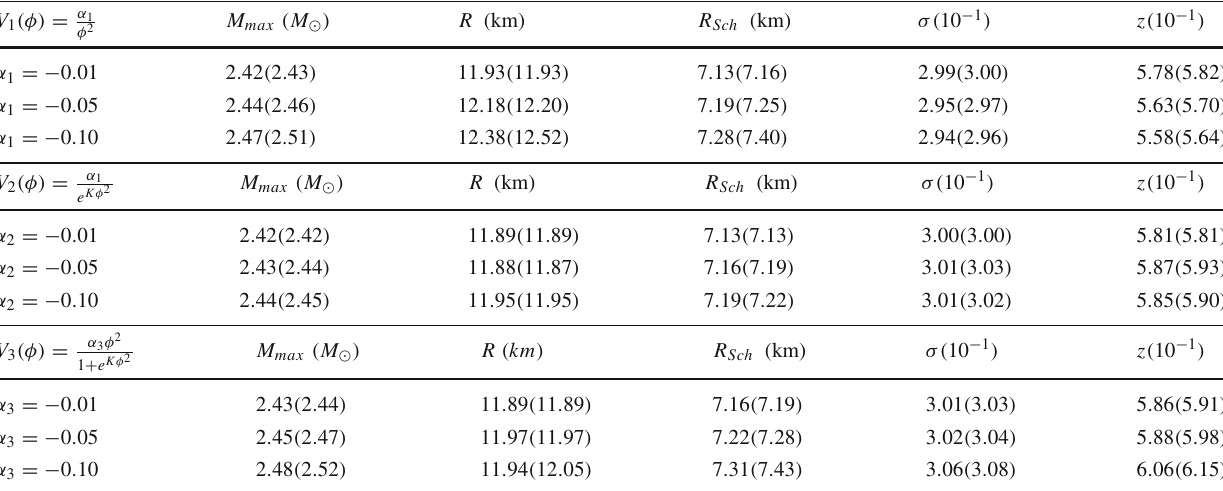
Table 7 Structure properties of neutron star in mimetic gravity for DD2 EoS with φ( 0 ) = 1 ( φ( 0 ) = 0 . 8) and K = 0 .